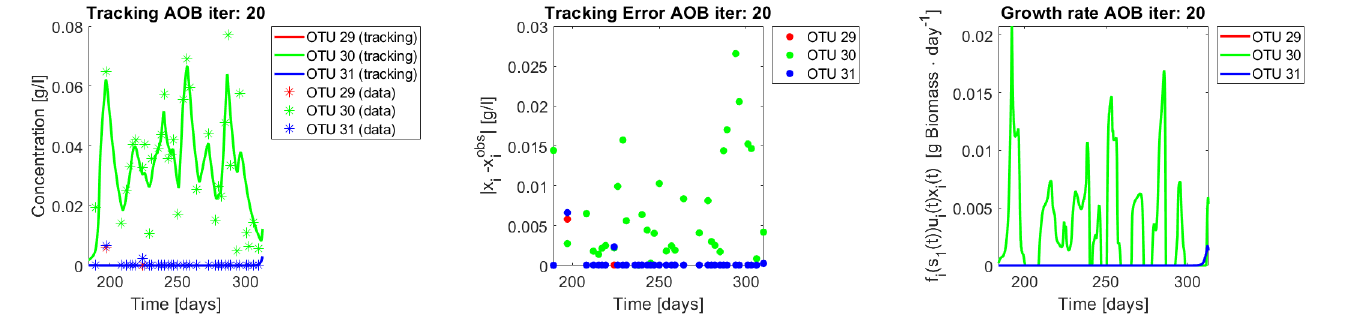
Figure 18. Results for OTU 23-28 (AOB).